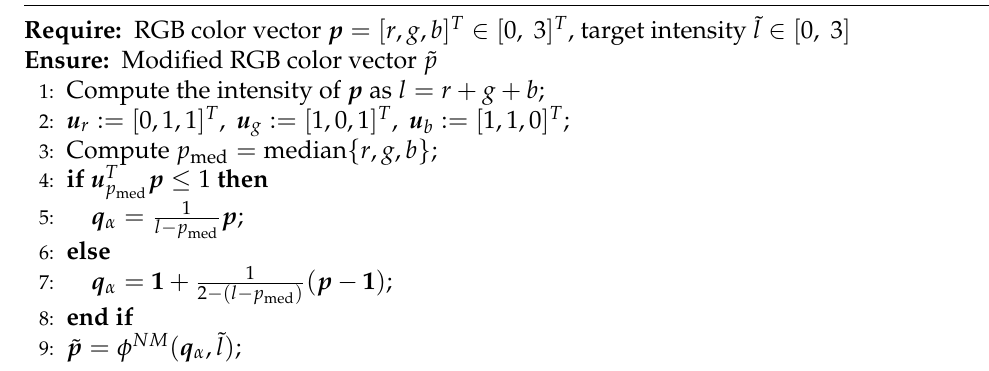
Algorithm 3 The proposed method.